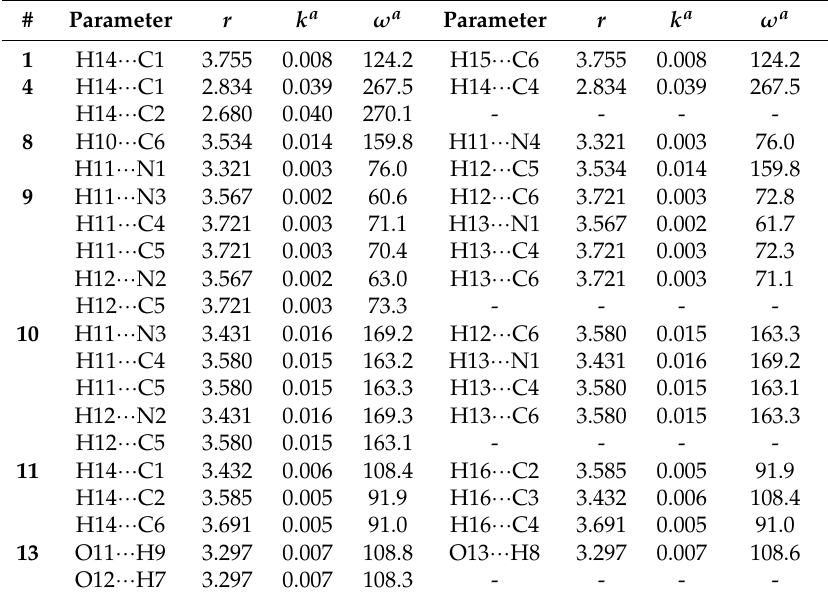
Figure 8. Schematic showing all atom numbers in 1–14 , for use as a reference to Tables 4 and 5. Table 4. LVM analysis: r , k a , and ω a , for secondary bonding interactions SBI involving hydrogen atoms in 1, 4, 8–11, and 13